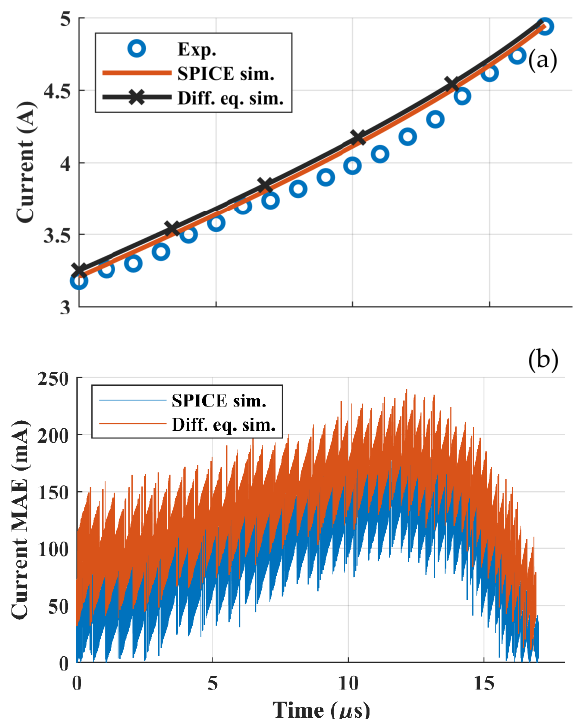
Figure 11. ( a ) Comparison of the experimental current waveform with the simulation results from SPICE and differential equation for a duty cycle of 51% at 70 °C. ( b ) Comparison of mean absolute error for SPICE and differential equation simulations. Table 4. Mean absolute error (in mA) of the inductor current for different duty cycles and tempera- tures for the SPICE simulations.